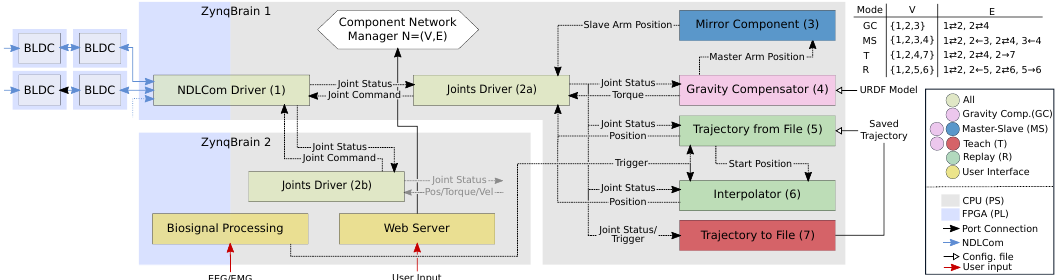
Figure 10. Software architecure overview: A Component Network Manager configures, connects and starts the subset of components (V) required for a specific mode. The corresponding directed connections (E) are described in the table in the top right corner. The components required for each mode are also represented by colors. A web server application hosted on ZynqBrain 2 is used as user